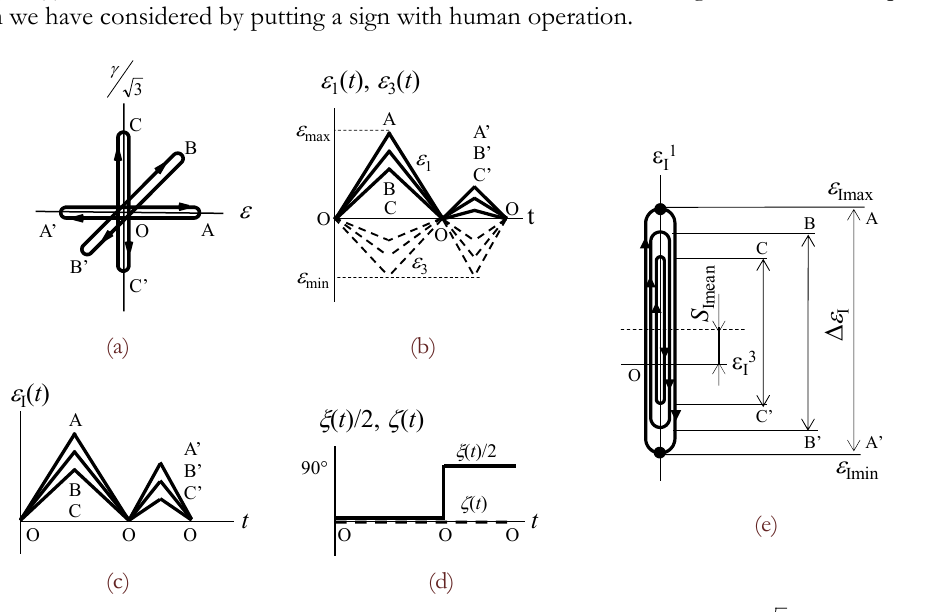
Figure 4: Variations of  i (t),  I ( t ) and  ( t )/2 in proportional straining: (a) Strain paths on  /  3 plot, (b) Variation of  i ( t ), (c) Variation of  I ( t ), (d) Variation of  ( t ) and  ( t ), (e) Strain paths on polar figure.